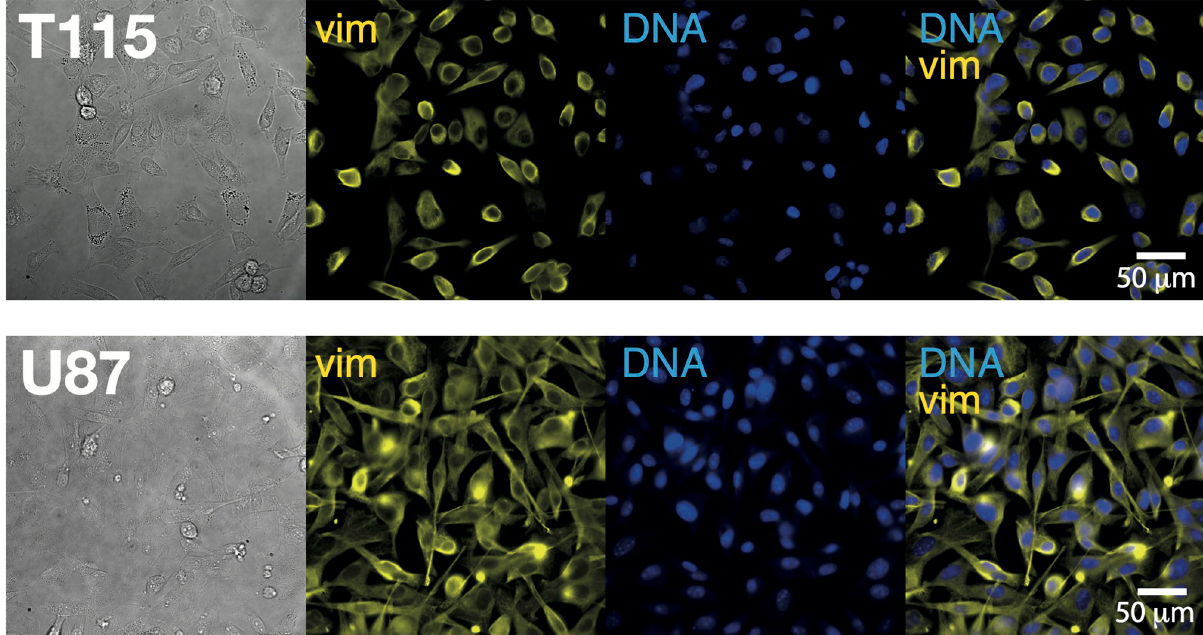
Fig 1. Vim marker expression in brain cancer cells. Immunofluorescence in parallel assays of vim (yellow) and cell nuclei identified by a nuclear stain (blue) in both GBM xenograft cell line T115 and cell line U87.